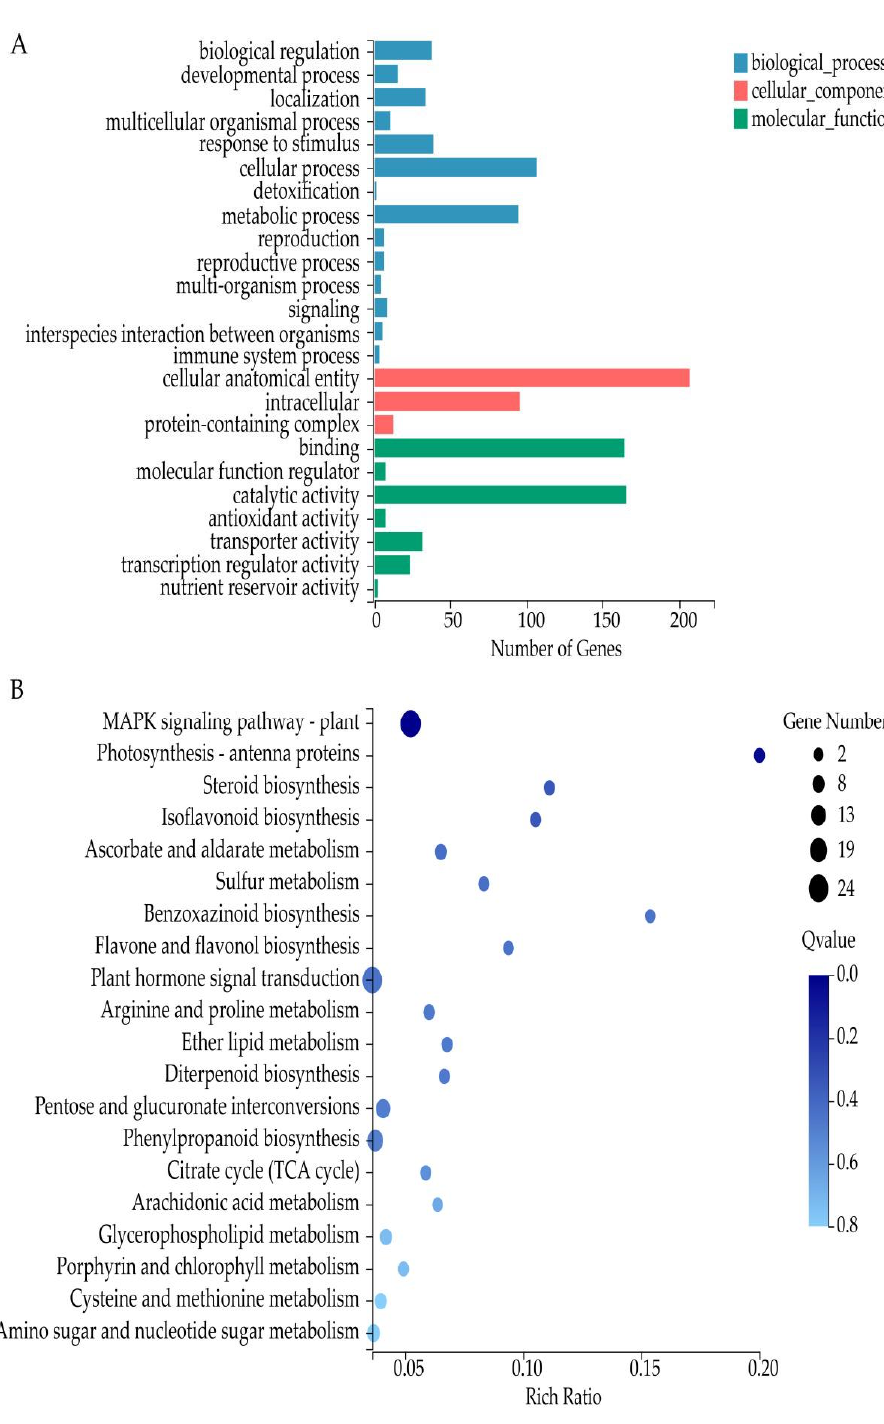
Figure 4. GO classification and KEGG pathway enrichment analysis of DEGs. ( A ) GO classification of DEGs. ( B ) KEGG pathway enrichment analysis of DEGs.